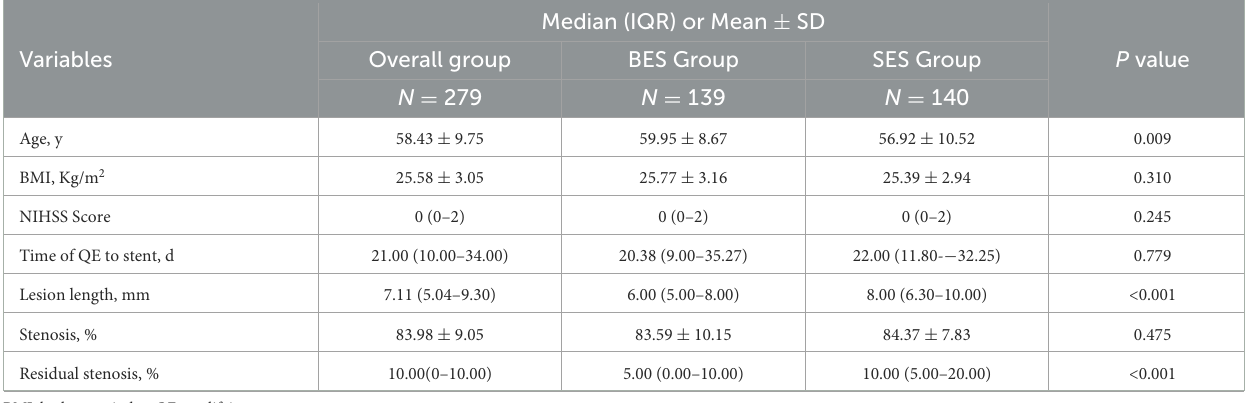
TABLE 2 Baseline continuous variables of patients in the overall group or stent subgroups.